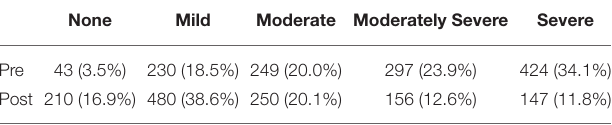
TABLE 2 | Classification of depression symptoms pre- and post-intervention (% of participants in each classification using PHQ-9).